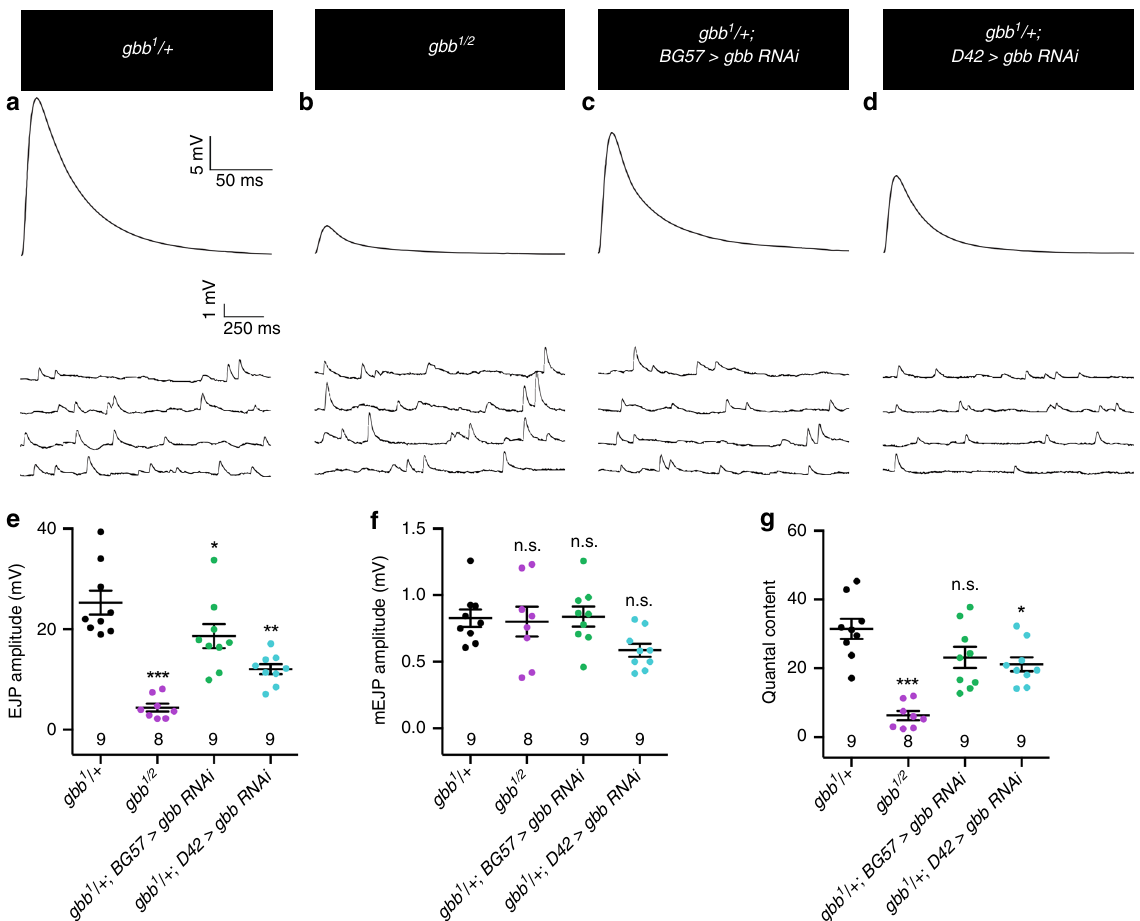
Fig. 4 Presynaptic Gbb is necessary for baseline synaptic function. a – d Representative EJP (upper) and mEJP (lower) traces for the indicated genotypes. e Quanti fi cation of EJP amplitude. f Quanti fi cation of mEJP amplitude. g Quantal content for each genotype was calculated by dividing average EJP amplitude by average mEJP amplitude. For all electrophysiological experiments, n is the number of cells recorded. Error bars are mean ± SEM. Individual data points are displayed as dots. n.s. not signi fi cantly different. * p < 0.05; ** p < 0.01; *** p < 0.001. All tests are one-way ANOVAs followed by Dunnett ’ s post hoc